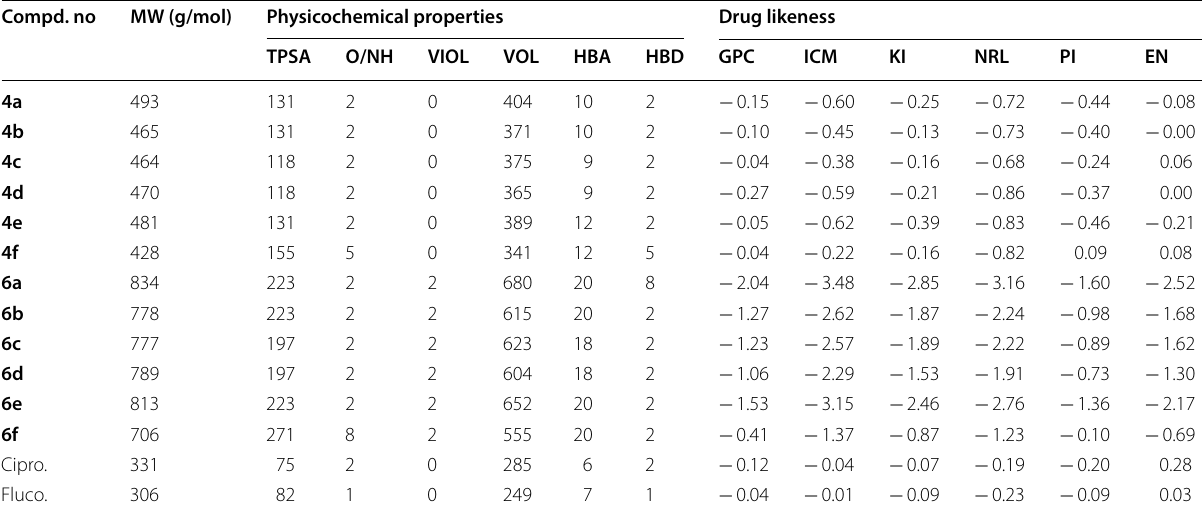
TPSA, total polar surface area; O/NH, O–HN interaction; VIOL, number of violation; VOL, volume; GPC, GPCR ligand; ICM, ion channel modulator; KI, kinase inhibitor; NRL, nuclear receptor ligand; PI, protease inhibitor; EI, enzyme inhibitor; Cipro., Ciprofloxacin; Fluco., Fluconazole; number of hydrogen bond donor (HBD) and acceptor (HBA)